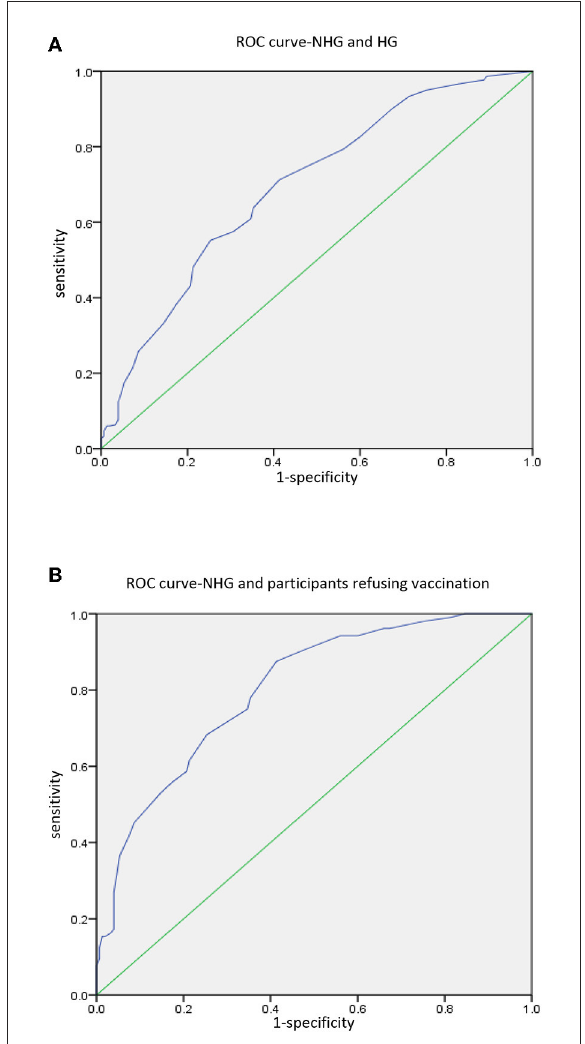
FIGURE2 ROC curve analysis. (A) Analysis between NHG and HG. (B) Analysis between NHG and participants refusing vaccination.